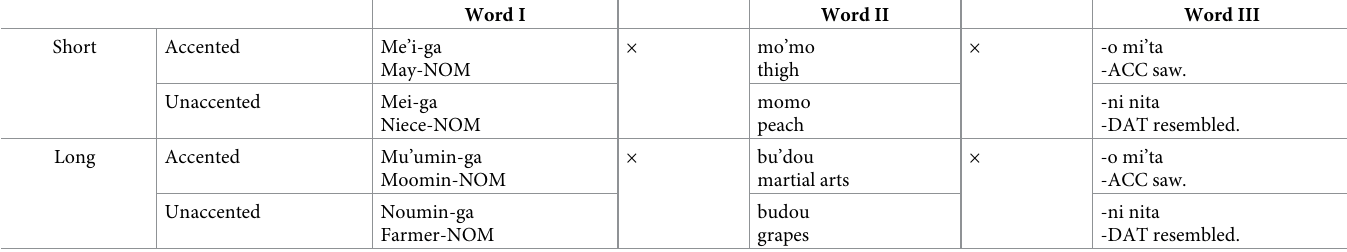
Table 1. Stimuli used in the present study [adapted from 9]. For easy illustration, here the accusative case marker– o (which collocates with mita ‘saw’) and the dative case marker– ni (which collocates with nita ‘resembled) are presented as though belonging to Word III; syntactically they are part of Word